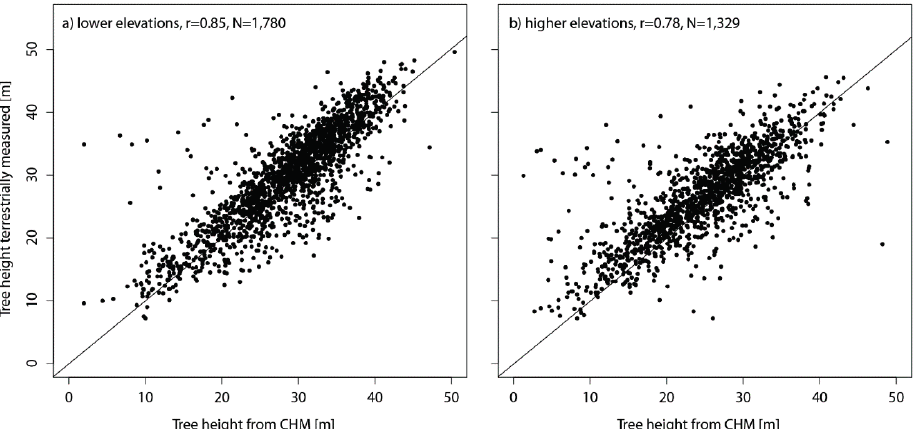
Figure A1. Correlation of tree height extracted from the CHM with terrestrial tree height measurements distinguishing between ( a ) deciduous and ( b ) coniferous trees. The total number of measurements was 3109. Tree height in the canopy height model refers to the maximum value within a buffer of 5 m diameter around each individual tree. Tree height in the field was measured using a Vertex ultrasonic hypsometer.